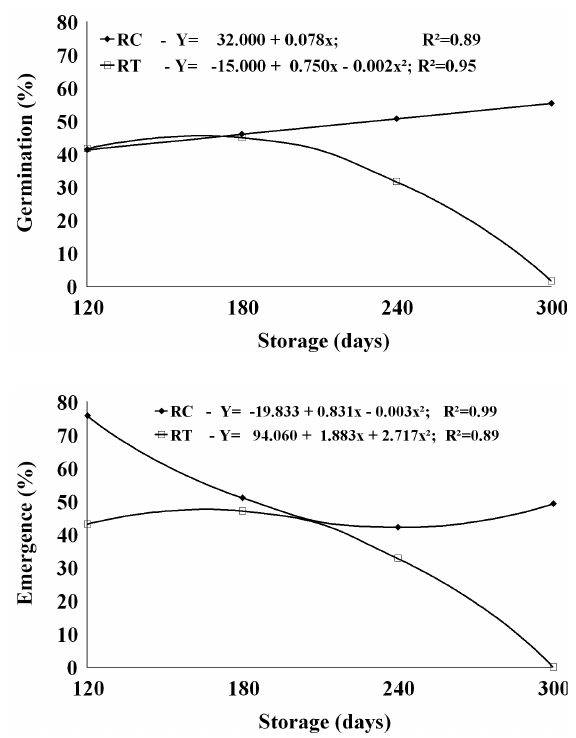
Fig. 2- Germination percentage of Croton urucurana seeds incubated at 20/30°C room temperature (a), and in under greenhouse condition (b) previously stored under refrigeration condition (RC) and at room temperature (RT). Fig. 3- First count of germination and emergence of Croton urucurana seeds incubated at 20/30°C previously stored under refrigeration condition (RC) and at room temperature